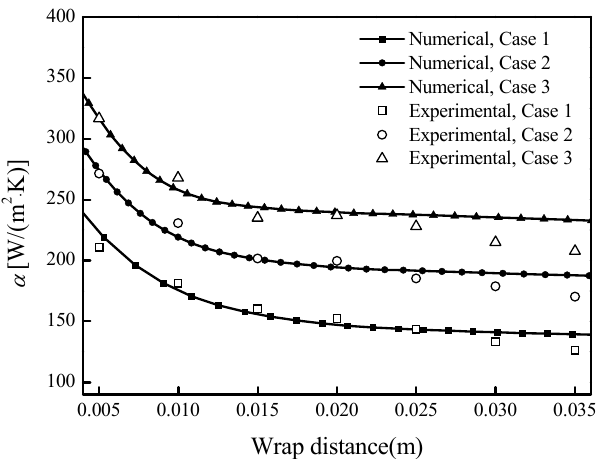
Figure 8. Comparisons of the convective heat transfer coefficients.